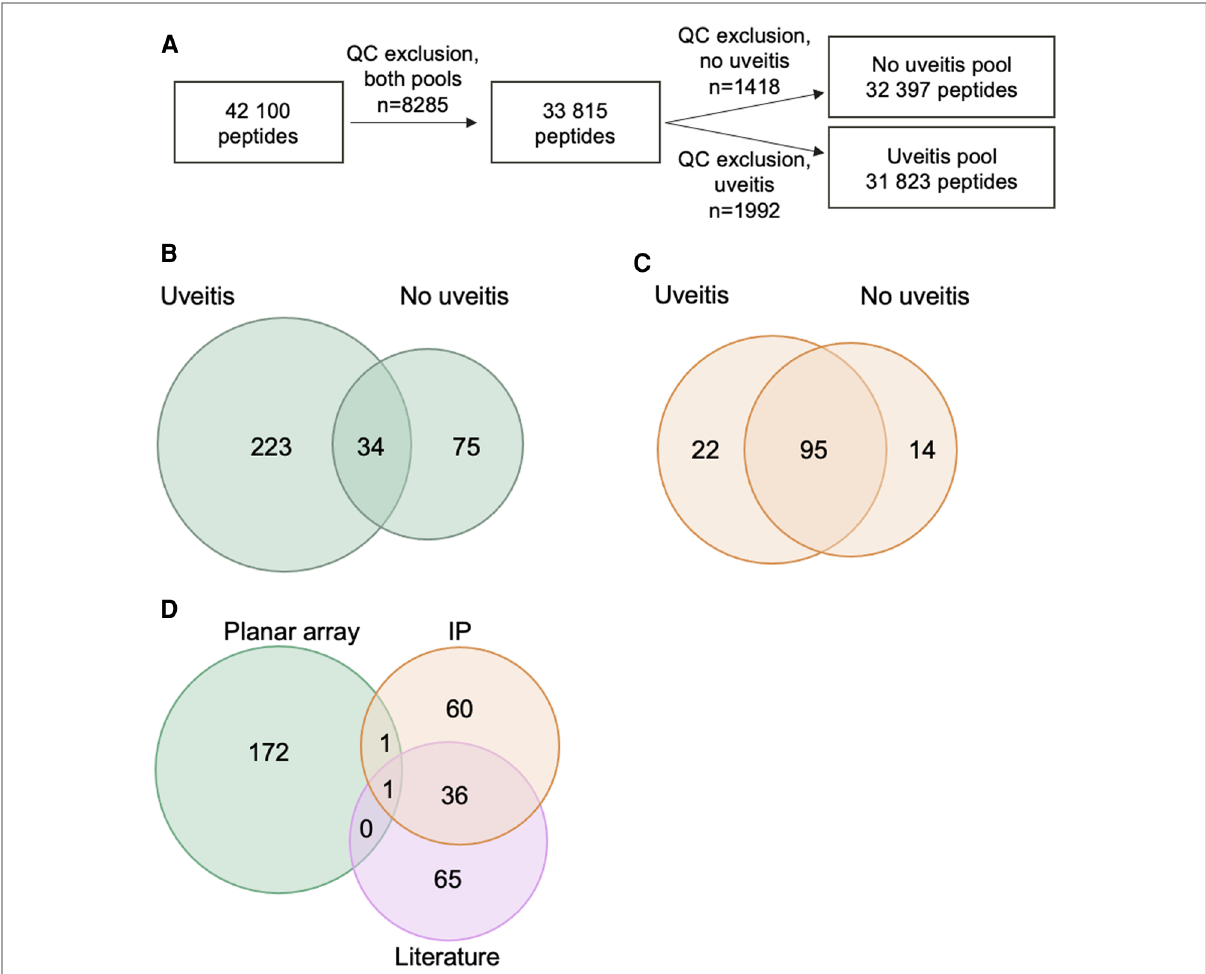
FIGURE 2 Peptides and proteins detected in large-scale screenings and selection for bead array. ( A ) Flow chart of number of PrEST antigens analyzed on planar array in each pool after quality control (QC) exclusions. ( B ) Venn diagram of PrEST antigen hits in the planar array in the two plasma pools. ( C ) Venn diagram of proteins precipitated by samples from patients in the two plasma pools. ( D ) Venn diagram of the 335 peptides included in bead array, based on source for